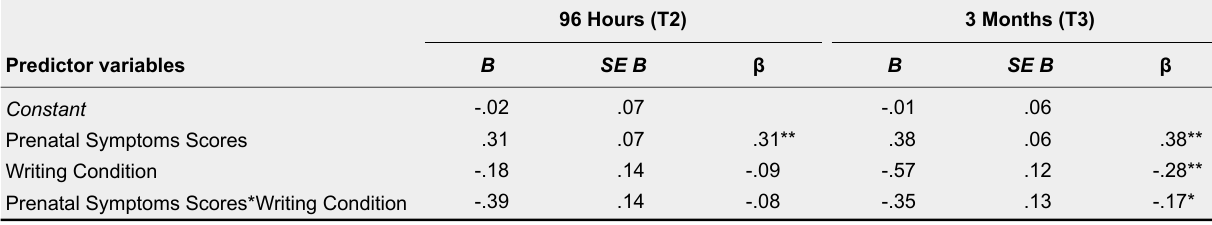
Regression Analysis Predicting PTSD Scores at 96 Hours (T2) and at 3 Months